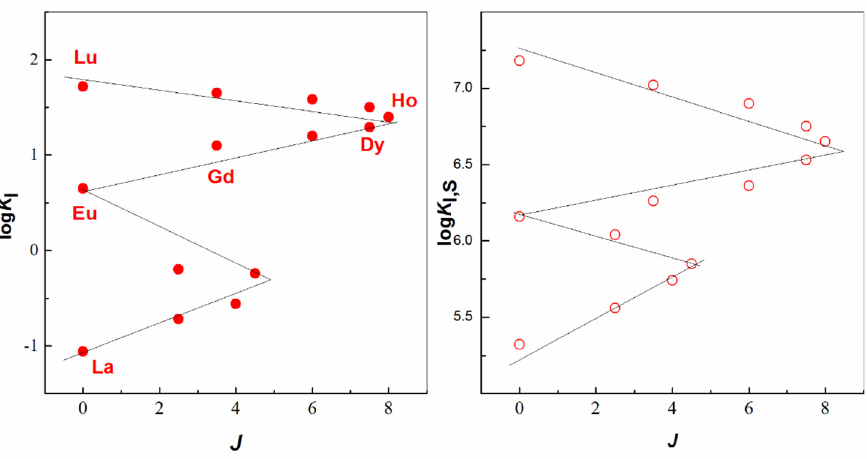
Figure 17. Variation of log K I ( K I,S ) values with the quantum number, J , of the rare earth ions. The straight lines are drawn for visual impacts only.